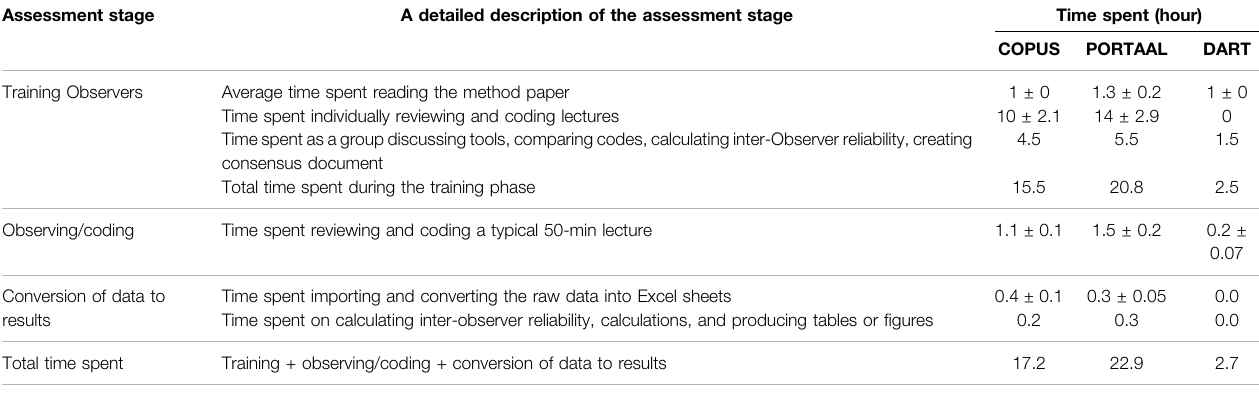
TABLE 5 | The amount of time (mean ± SD) Observers spent, in hours, during the training, reviewing/coding, and curating raw data when working with COPUS, PORTAAL, and DART to assess a typical 50-min Course lecture.